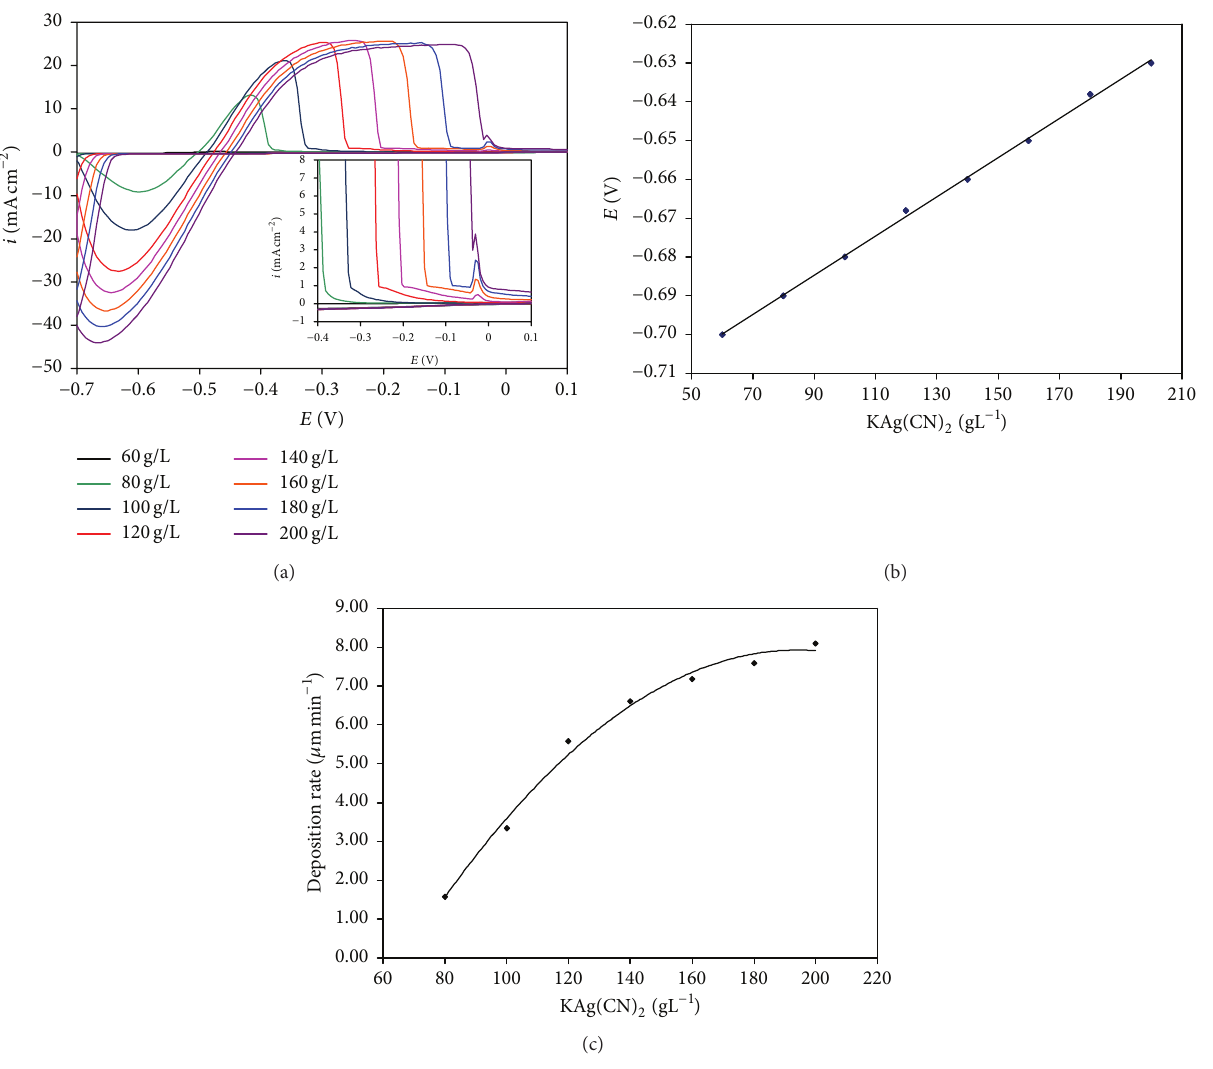
Figure 2: (a) Cyclic voltammograms of silver electrodeposition and silver dissolution in the solutions consisting of 6 g/L KCN, 120 g/L KNO 3 , and 60–200 g/L KAg(CN) 2 . Inset: the current response of second anodic peak increases with increasing KAg(CN) 2 concentration during the anodic scan. (b) The effect of KAg(CN) 2 concentration on the onset potential of silver electrodeposition. (c) The influence of KAg(CN) 2 concentration on the electrodeposition rate in the sweeping potential range from +0.6 V to − 0.7